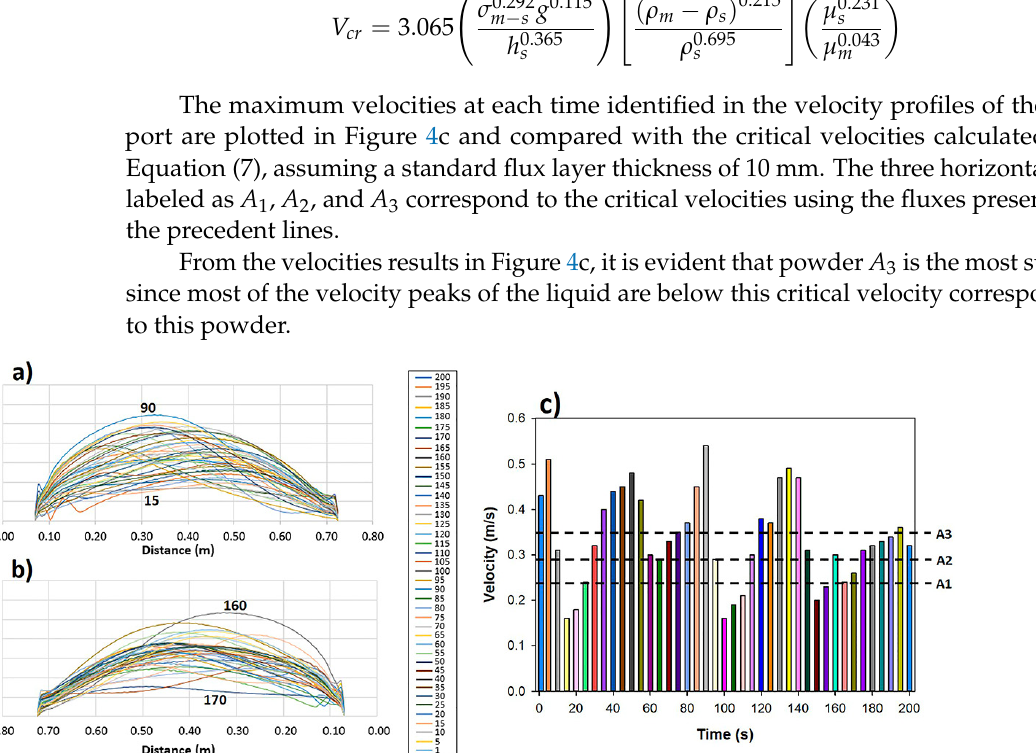
Figure 4. Velocities calculated along a line located 20 mm below the meniscus by the mathematical model: ( a ) right port, ( b ) left port. ( c ) Comparison of meniscus velocities with critical velocities to induce powder entrainment.